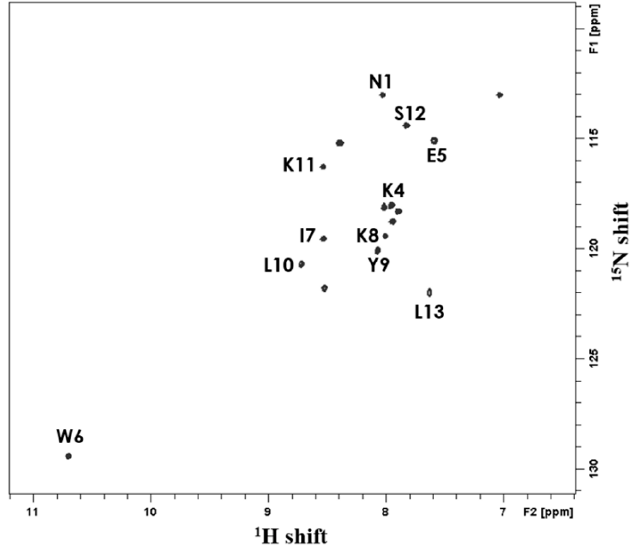
Figure 6. 1 H − 15 N HSQC spectrum of uniformly 15 N labeled YK5 in DPC micelle. The 1 H − 15 N cross-peaks were identified on the HSQC spectra of YK5 based on 1 H − 15 N 2D HSQC spectra of selectively 15 N-labeled peptides and 2D HMQC-NOESY spectra of uniformly 15 N-labeled peptides.